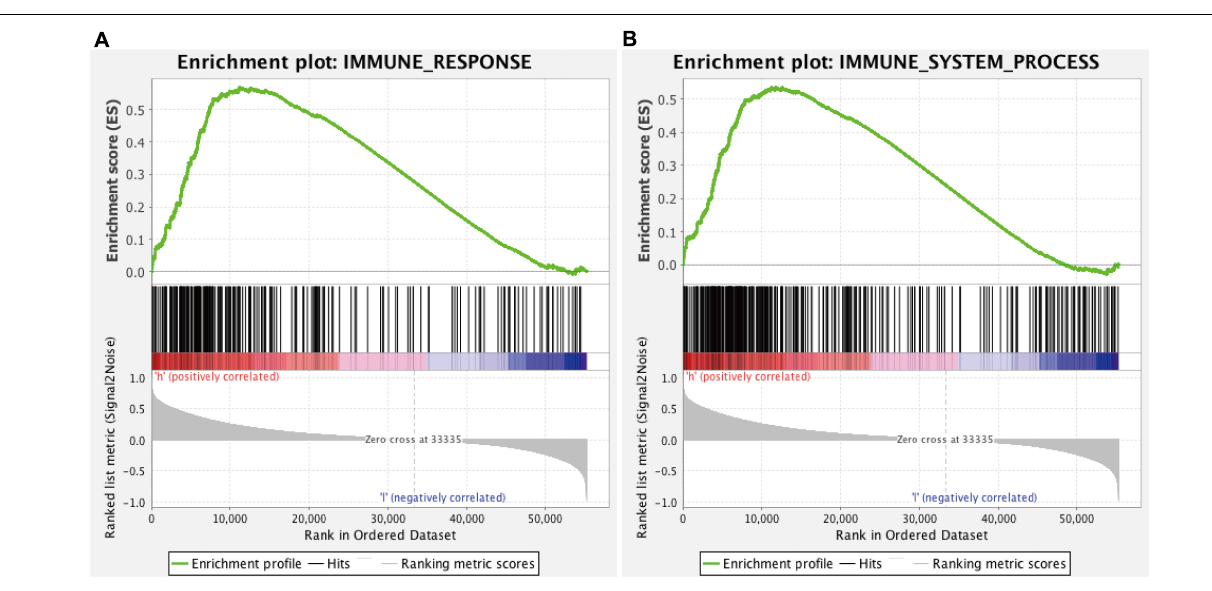
FIGURE 8 | GSEA for comparing immune response (A) and immune system process (B) between low- and high-risk